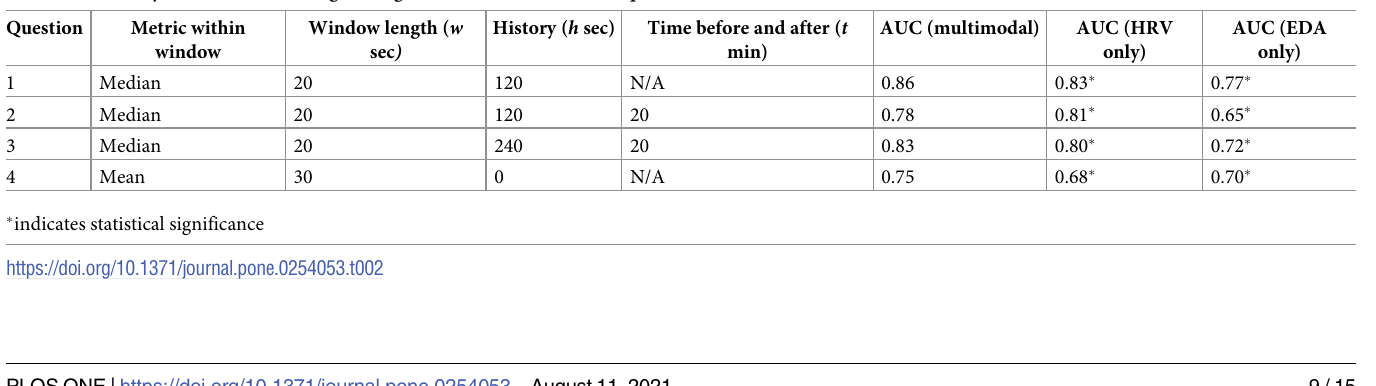
Table 2. Summary of results for best logistic regression models for all four